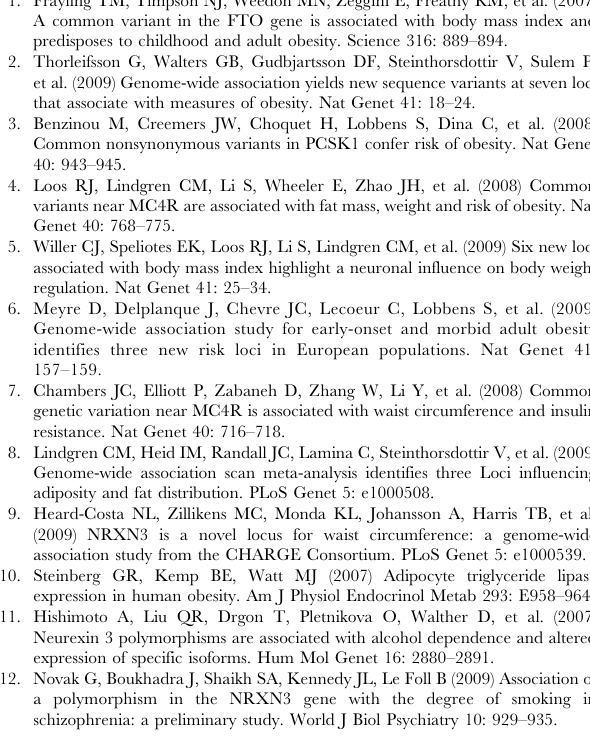
lence= 0.23 (Men with waist circumference $ 94 cm and , 102 cm and women with waist circumference $ 80 cm and , 88 cm from the Inter99). General overweight: , 3,200 controls and , 7,000 overweight individuals. Prevalence= 0.39 (Individuals with BMI $ 25 kg/m 2 and BMI , 30 kg/m 2 from the Inter99). Central obesity: , 4,500 controls and , 7,000 obese individuals. Preva- lence= 0.22 (men with waist circumference $ 102 cm and women with waist circumference $ 88cm from the Inter99). General obesity: , 3,200 controls and , 4,800 obese individuals. Prevalence=